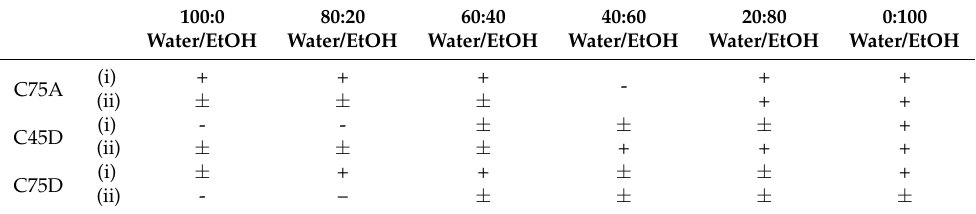
Table 1. Symbolic description of prostheses obtained from different nonsolvent solutions ( n =